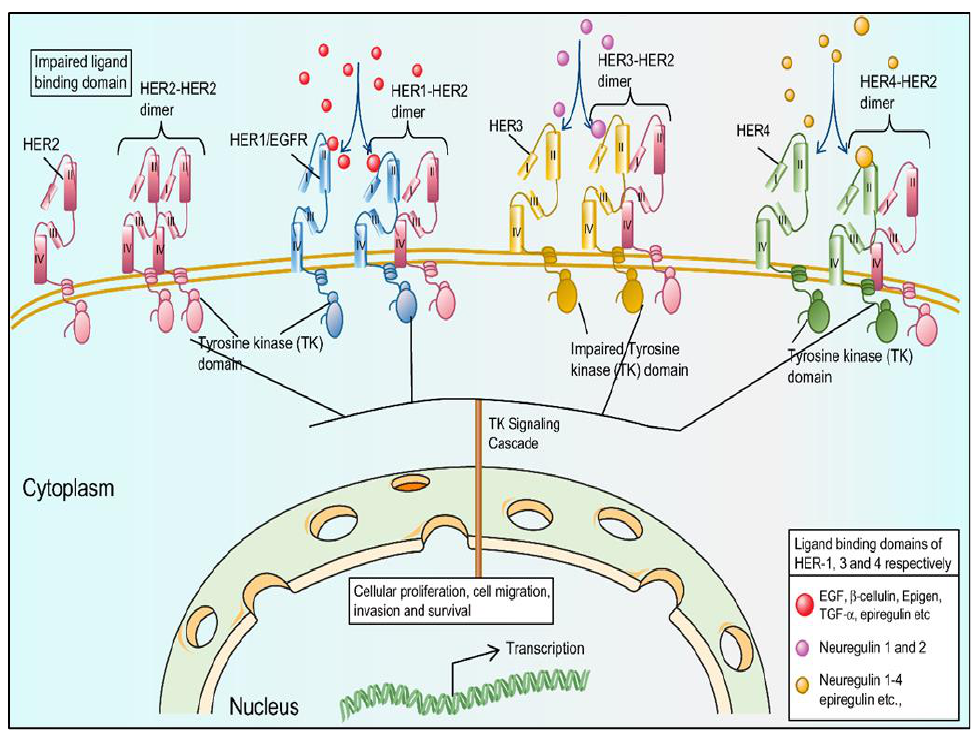
Figure 1. The HER family of tyrosine kinases (TK) receptors have various ligand-binding capabilities that help orchestrate several biological processes in normal cells. The HER family of receptors comprises HER1, HER2, HER3, and HER4, depicted in blue, magenta, golden, and green, respectively. All members of the HER receptor family are structurally similar, containing an extracellular domain with a ligand-binding site (except HER2), a lipophilic transmembrane domain, and a TK intracellular domain (except for HER3). The TK domain of HER1, HER2, and HER4 is activated following homo- or heterodimerization and evokes a signaling cascade that activates a receptive gene, leading to cell proliferation, migration, invasion, or cell survival.